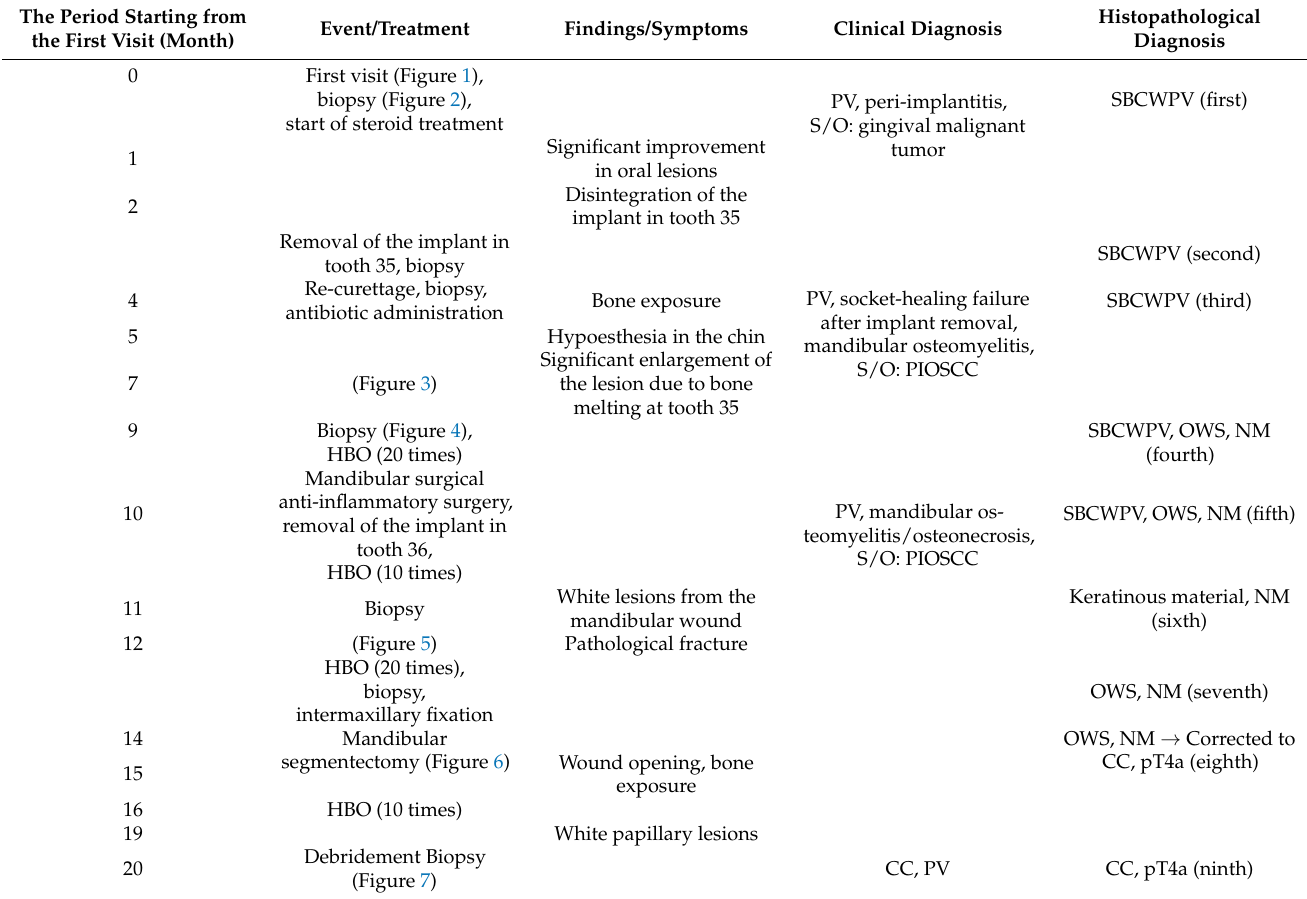
Table 1. Summary of the clinical course until the diagnosis of carcinoma